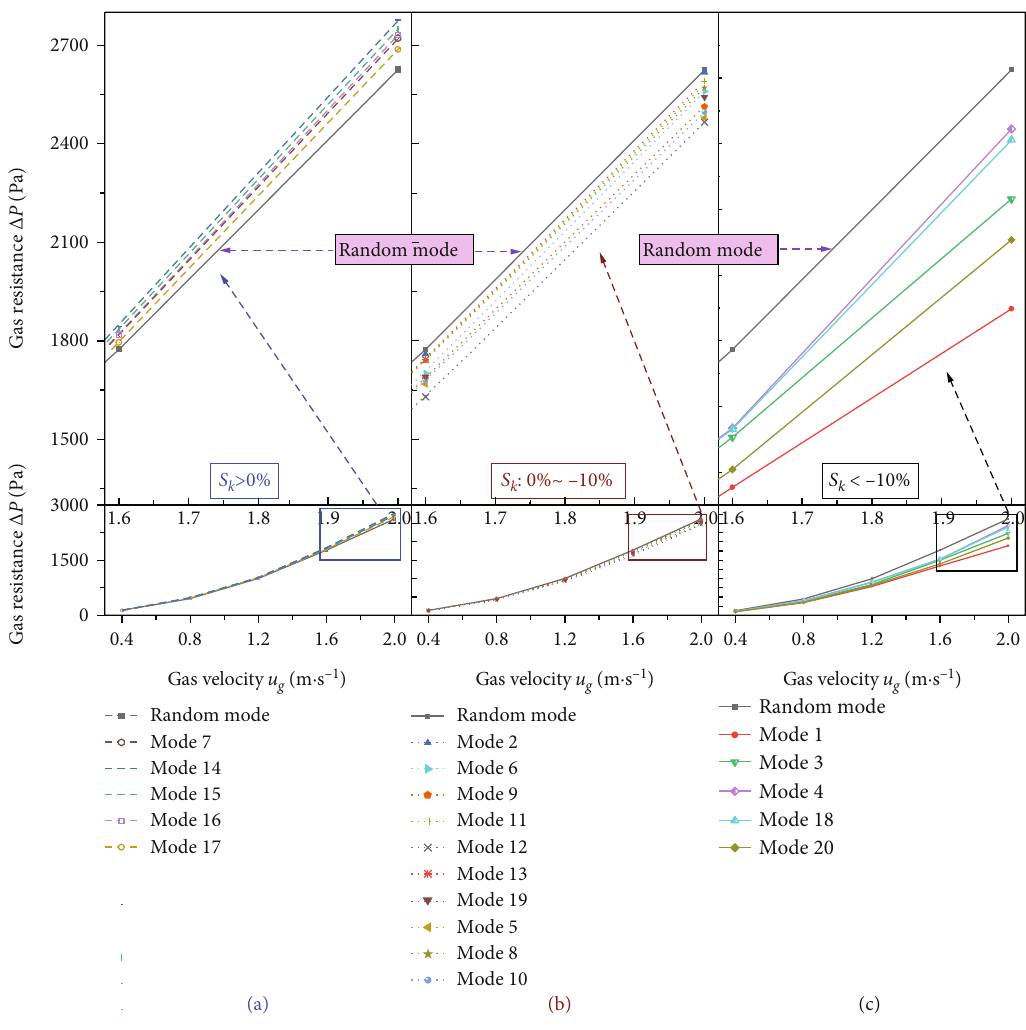
Figure 10: The comparison of the gas fl ow resistance Δ P between the fi ve-layer layered mode and the random distribution mode based on the sinter mixture with the equivalent particle diameter of 11.45mm: (a) the ratio of the resistance increase S k > 0 % ; (b) the ratio of the resistance increase S k : 0% ~ -10%; (c) the ratio of the resistance increase S k <